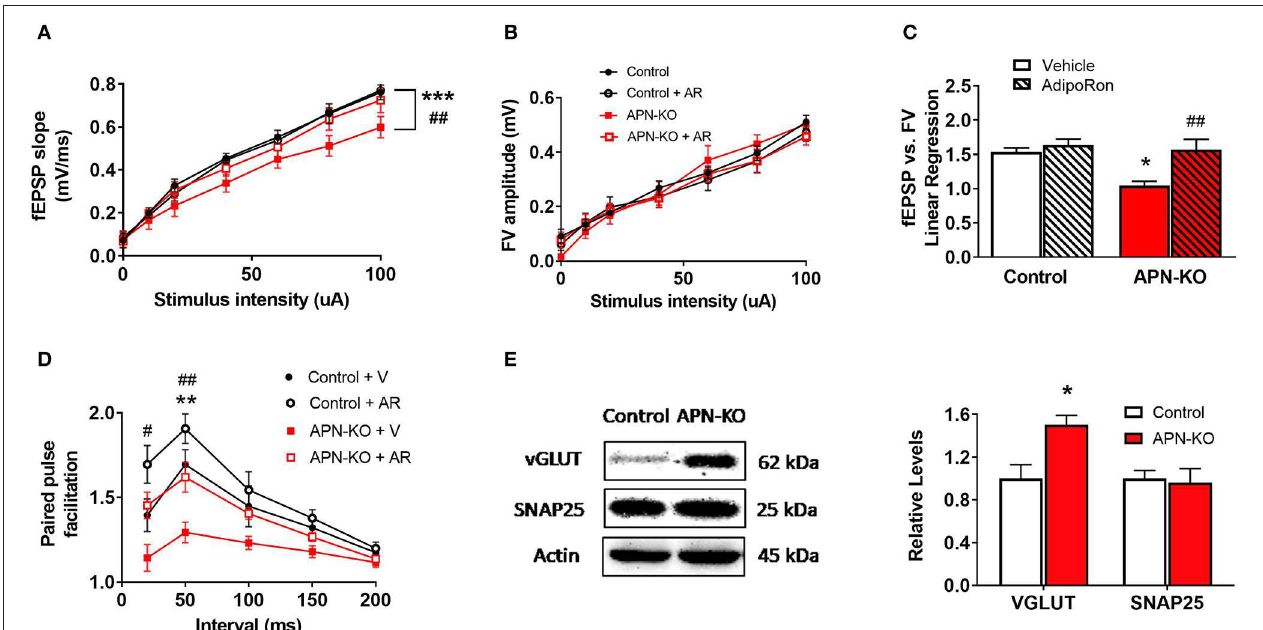
FIGURE 3 | APN-KO mice display alterations in basal synaptic transmission and paired pulse facilitation which are rescued through incubation with AdipoRon. For (A–D) , hippocampal slices were prepared from Control and APN-KO mice and incubated for 2-h in either ACSF containing 0.03% DMSO [Vehicle (V)] or ACSF containing 15 µ M of AdipoRon and 0.03% DMSO [AdipoRon (AR)] prior to recording. (A) Input-output curve of fEPSP slope measured at increasing stimulus intensities. (B) Input-output curve of FV amplitude measured at increasing stimulus intensities. (C) Slope of the linear regression line of best fit from plotting fEPSP slope vs. FV amplitude. (D) Paired-pulse facilitation expressed as the change in ratio of the second stimulus fEPSP to the first stimulus fEPSP slope plotted as a function of interstimulus interval. (E) Representative immunoblot showing vGLUT1 and SNAP25 relative densities normalized to beta actin in total hippocampal lysate. Forty micrograms of protein were loaded per lane. Symbols/bars represent mean ± SEM; *indicates significant difference between APN-KO and Control, # indicates significant difference between APN-KO and APN-KO + AR; */ # p < 0.05, **/ ## p < 0.01, *** p < 0.001; for (A–D) , n = 5–6 slices from 4 mice per group; for (E) , n = 4 mice per group; for (A–C) , Tukey’s post hoc test was used for multiple comparisons; for (D) , planned pairwise comparisons were performed for individual data point analysis for Control vs. APN-KO, APN-KO vs. APN-KO + AR, and Control vs. APN-KO +